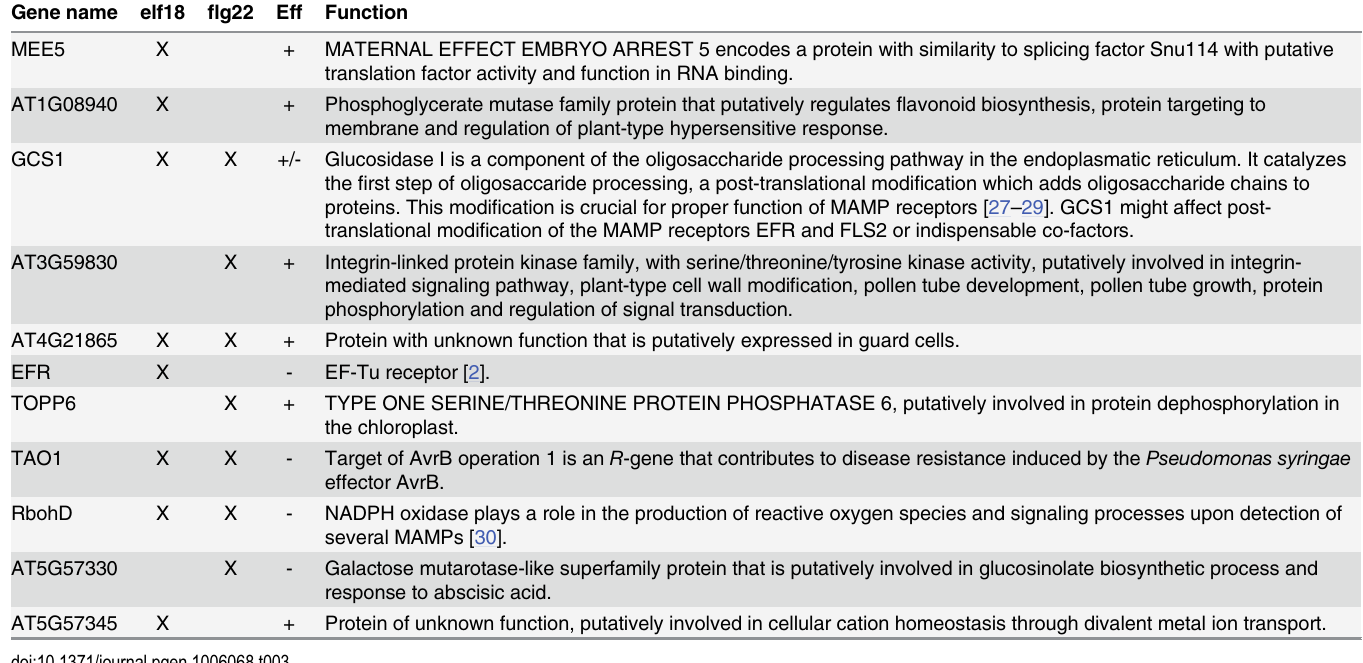
were tested for SGI. We identified 11 candidate genes that significantly alter SGI (Table 3), some of which are a priori candidates such as EFR and RbohD , while others are genes of unknown function (e.g., AT4G21865 and AT5G57345). We consider as confirmed only candi- dates that pass q (cid:1) 0.05 after correction for false discovery rate. This approach reduces the reporting of false positives but might exclude some true positives (e.g, RIN4, involved in modu- lating flg22-induced SGI [26].) Our confirmation of 11 genes reveals a four fold enrichment in Table 3. The majority of confirmed loci exhibit MAMP-specific responses. The first column indicates the candidate gene name. The columns elf18 and flg22 denote whether differential SGI was observed in response to either MAMP in mutant plants (an X indicates that a member of the peptide class induced differential SGI significance at FDR < 0.05). The column “ Eff ” denotes if SGI was stronger (+) or weaker (-) in the mutant in comparison to the wild-type Col-0. The magnitude of response differs between several of the validated candidates (see S6 Table). Information from the Arabidopsis Information Resource (www.arabidopsis.org) is given for genes that have not been previously associated with